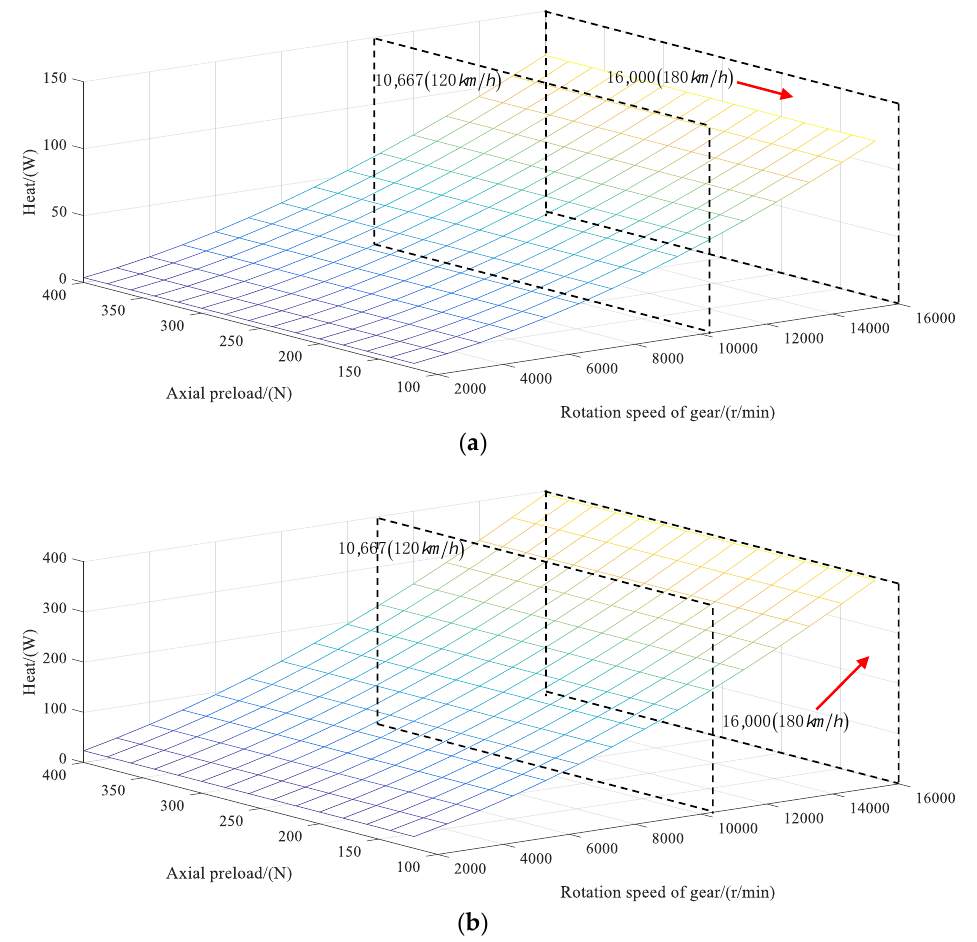
Figure 6. Calorific values of bearing under different loading conditions: ( a ) no load and ( b ) the load with the input torque of 100 Nm.